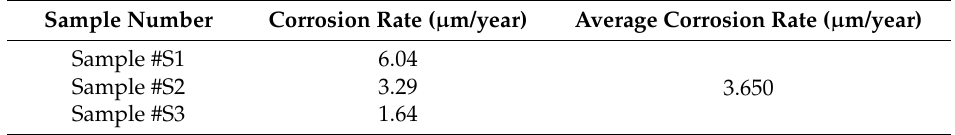
Table 3. Corrosion rate after the cutting damage was manually made to polymeric coating samples.